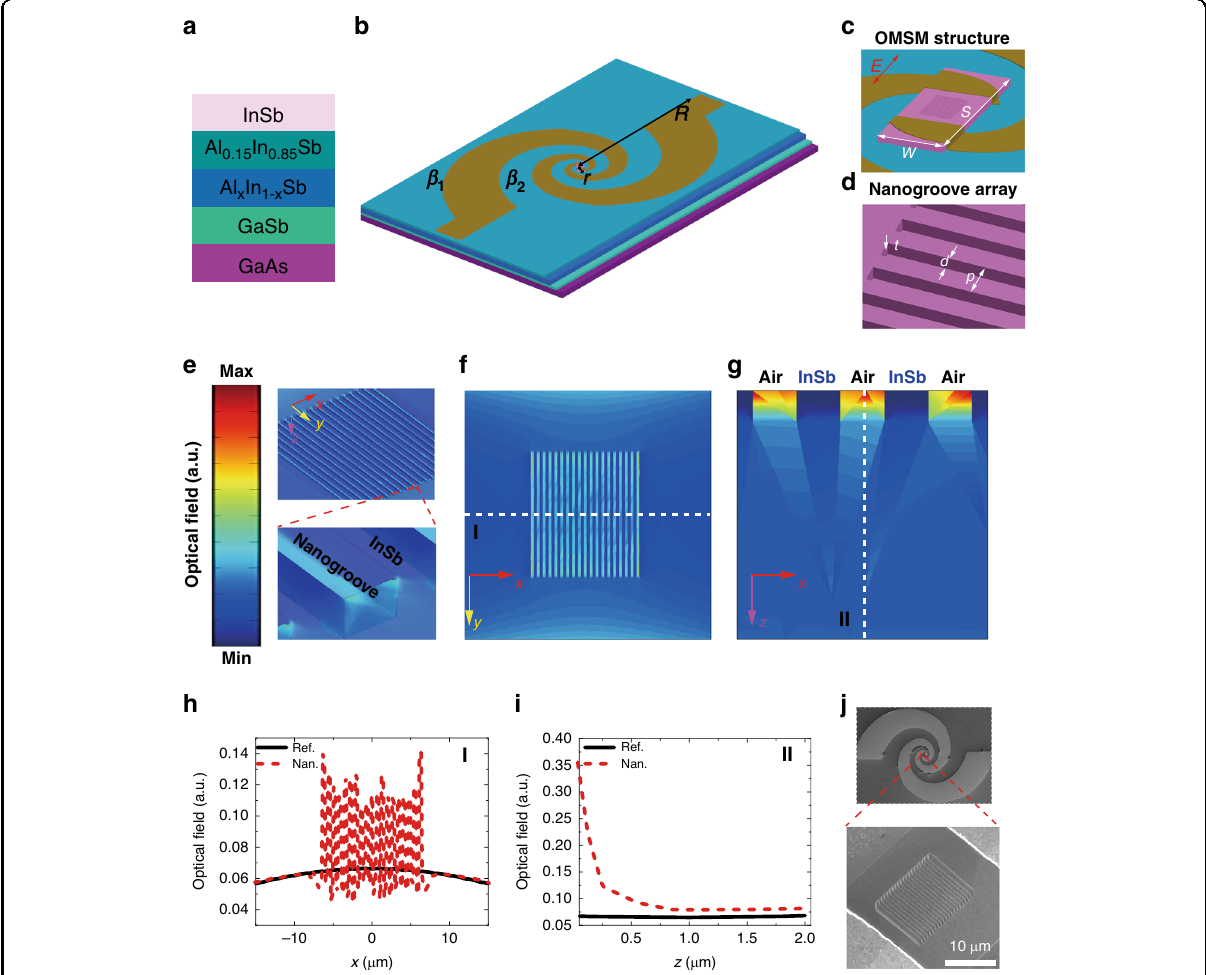
Fig. 1 InSb device design. a Structure of the epitaxially grown InSb on GaAs substrate. b Schematic of the spiral antenna-assisted device. R and r are respectively the out and inner radius of the antenna. β 1 and β 2 represent curves of the arm. c The central ohmic metal – semiconductor – metal (OMSM structure). s (50 µm) and w (30 µm) are the length and width of the mesa between ohmic contacts. E denotes the TM polarization orientation (to arouse SPPs in nanogroove array) of incident electromagnetic waves. d Nanogroove array. The period p , width d , and depth t of the nanogroove are 700, 350, and 250 nm, respectively. e Distribution of simulated optical fi eld for nanogroove InSb device at 0.171THz. f Distribution of the fi eld at xy plane ( z = 250 nm, bottom plane of the nanogroove array). g Distribution of the fi eld at xz ( y = 0) plane. Optical fi eld distribution along cut-line I ( h) and cut-line II ( i ) as denoted in f and g , respectively. j Scanning electron microscopy image of the plasmonic nanogroove InSb device. The bottom panel is the zoom-in view of the nanogroove array